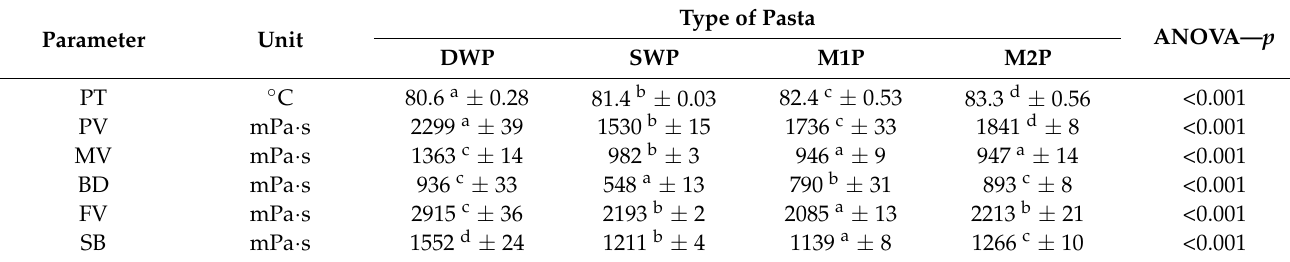
Table 4. Parameters of pasting characteristics of dry